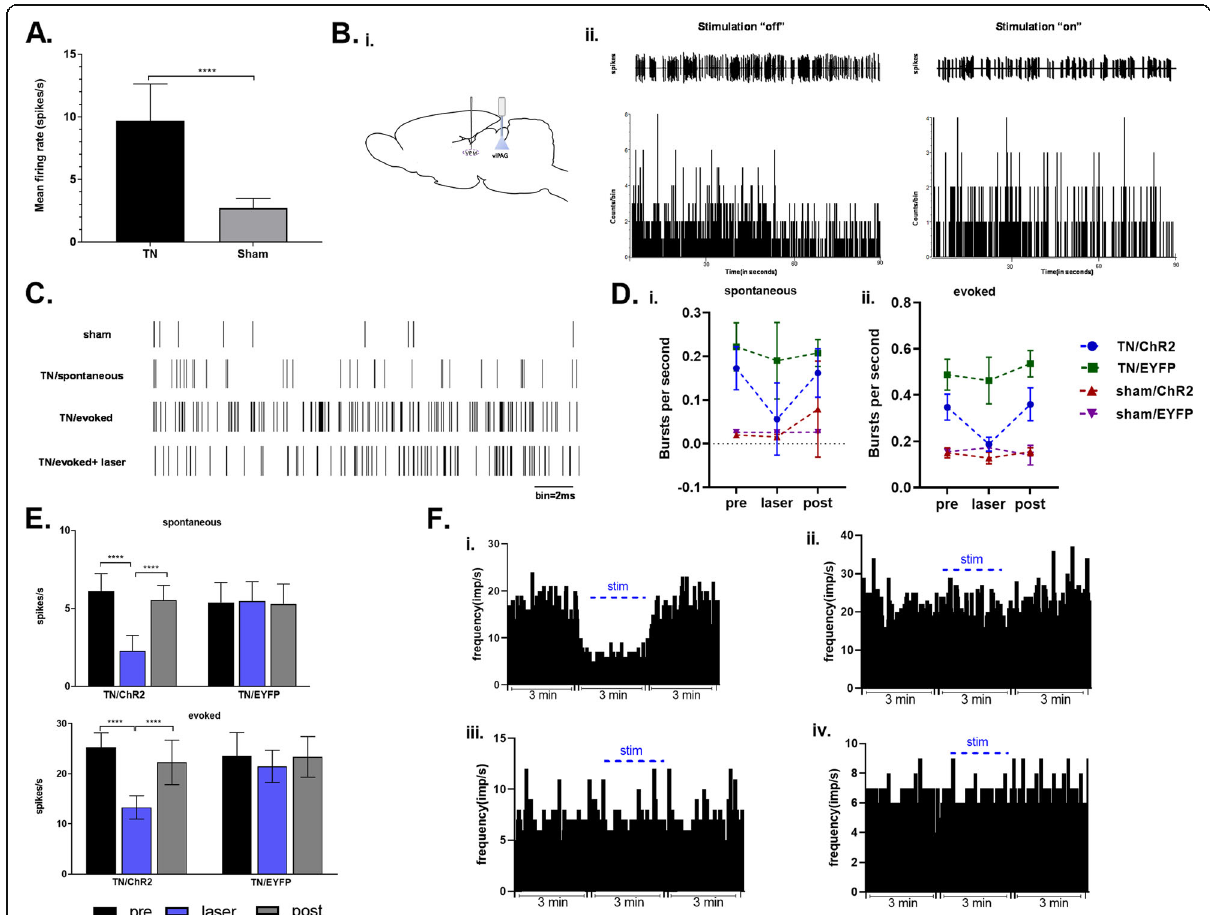
Fig. 4 Electrophysiological findings from VPM thalamus under optogenetic stimulation of vlPAG. a Mean firing rates in VPM neurons in TN animals against sham animals (****, p <0.0001, significant variation defined using unpaired t-tests). b i. Schematic diagram showing recording area and optic stimulation area. ii. Representative spike traces (above) and rate histogram (below) obtained from a TN/ChR2 rats in blue laser stimulation on and off conditions. c Representative raster traces recorded from VPM thalamus of TN and sham animals. d Spontaneous(i) and evoked (ii) in vivo burst recordings obtained from the VPM thalamus during different light conditions. e Spontaneous and evoked mean firing rate (expressed in spikes per second) from TN/ChR2 and TN/EYFP rats in different laser conditions. f Representative firing frequencies (expressed as impulses per second) observed in animal groups (i. TN/ChR2, ii TN/EYFP, iii. Sham/ChR2, iv. sham/ EYFP) through various light frame. ****, p <0.0001, significant difference determined via two-way analysis of variance